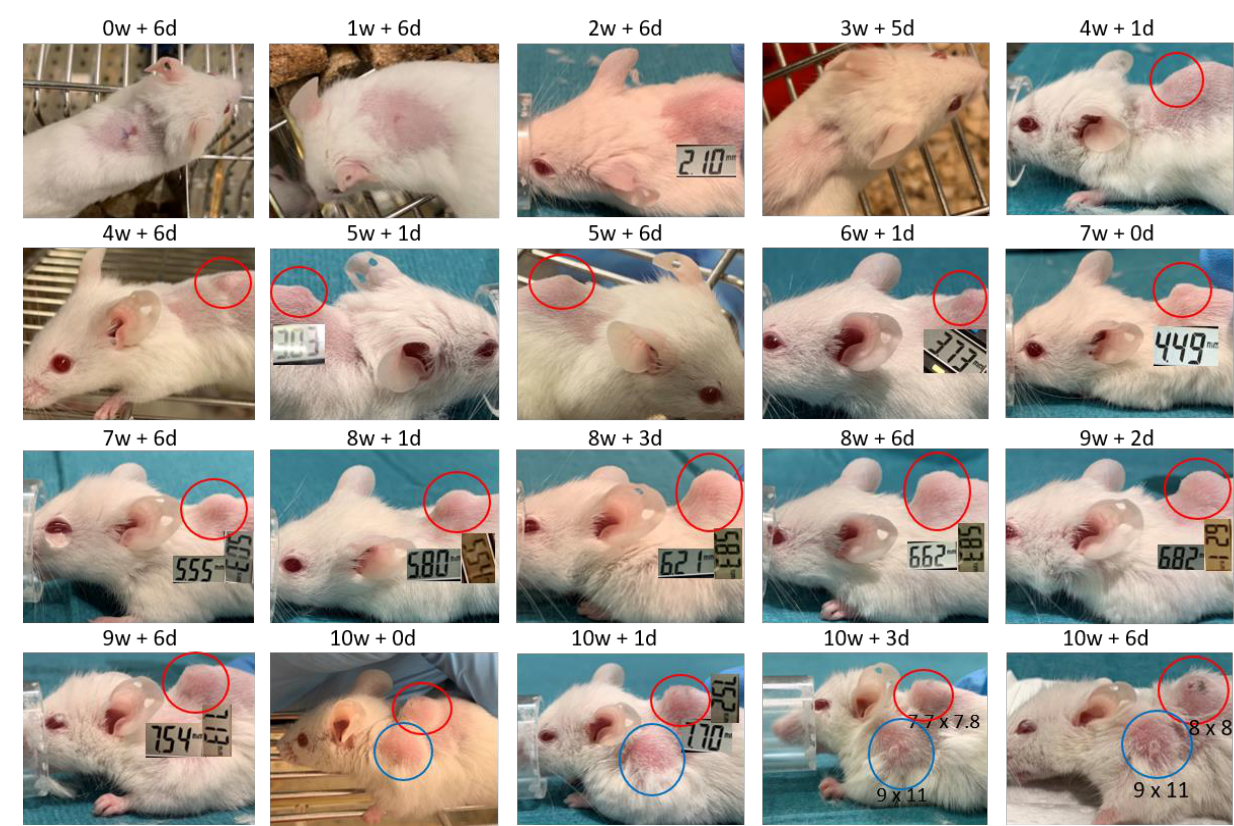
Figure 9. Images of PDX growth (red ring) for mouse #26 (patient 17). Secondary tumor from week 10 (blue ring). Numbers are millimeter (mm) length of the tumor in two dimensions. W = week, d = days.